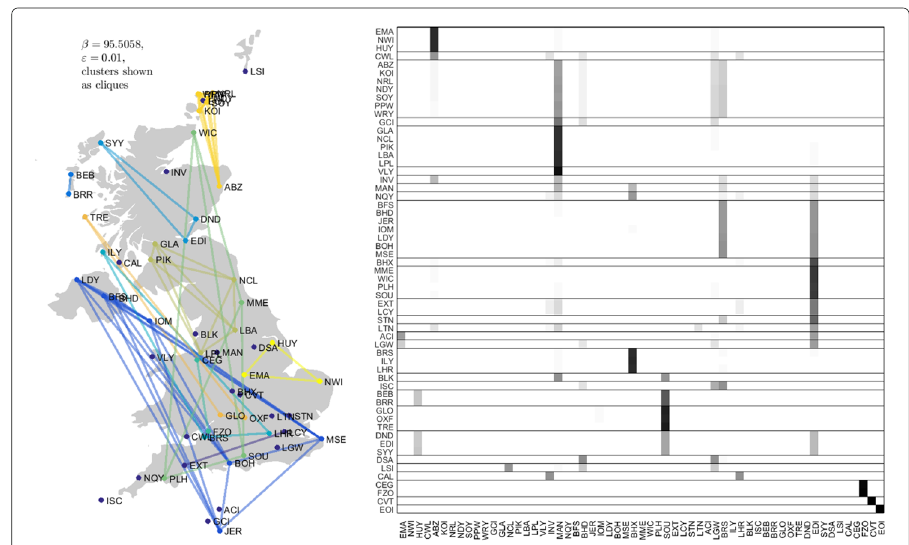
Fig. 5 Clusters from UK flight data for Monday, 18 October 2010 obtained using total variation distance in (20) and single linkage, with a dendrogram cutoff automatically selected along the lines mentioned in “Data reduction and anomaly detection” section. (L) Clusters displayed as cliques. (R) Transition matrix for β = 1 / (cid:27) (cid:4)τ (cid:28) and ε = 10 − 2 , with entries indicated by grayscale and indices/airports permuted to reflect clusters, which are themselves delineated by horizontal lines